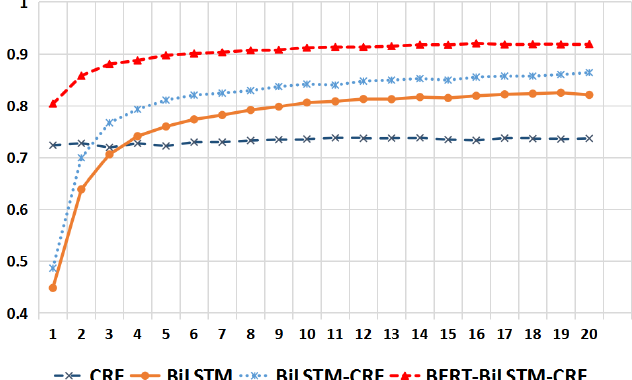
Figure 8. The comparison of each model’s updated F1 scores.